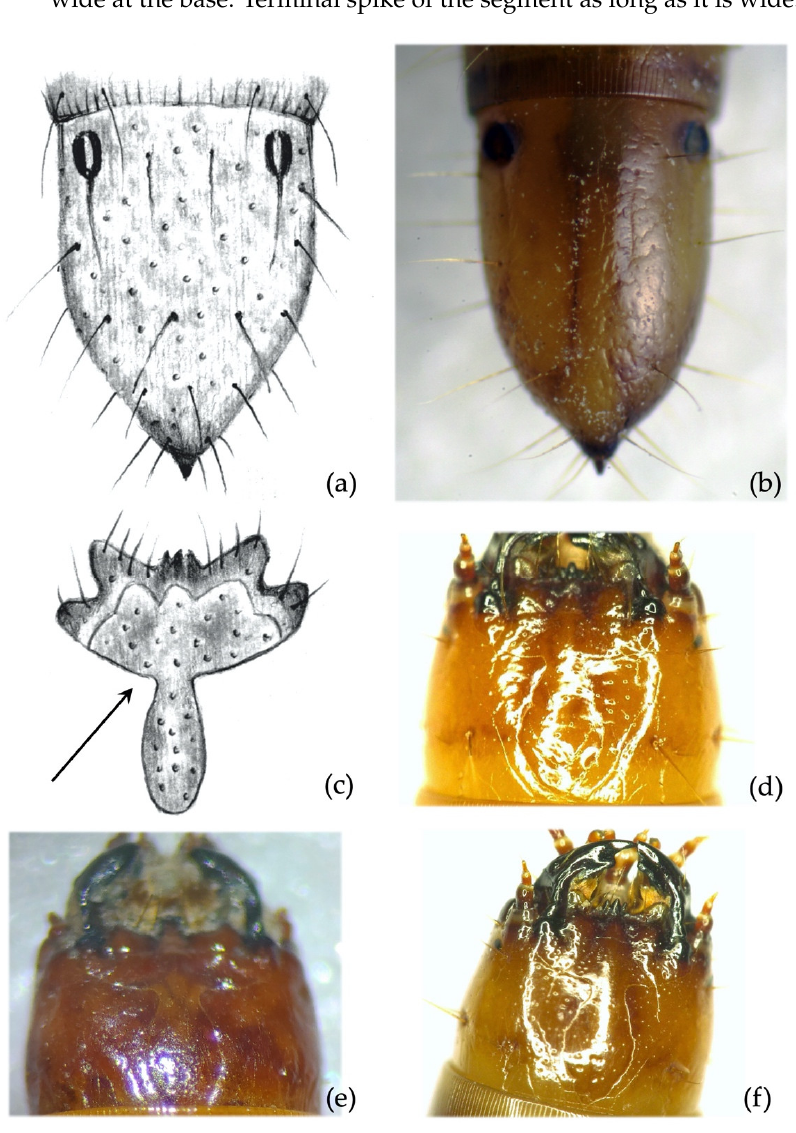
Figure 11. Agriotes obscurus (L. 1758). Discriminating characters: ( a , b ) 9th abdominal segment, dorsal view; ( c ) details of the frontoclypeus forming an angle from 90–100 ◦ . Different aspects of clypeus in different species: ( d ) densely punctured in A. obscurus ; ( e ) not punctured in A. litigiosus ; ( f ) scattered punctures in A. lineatus .